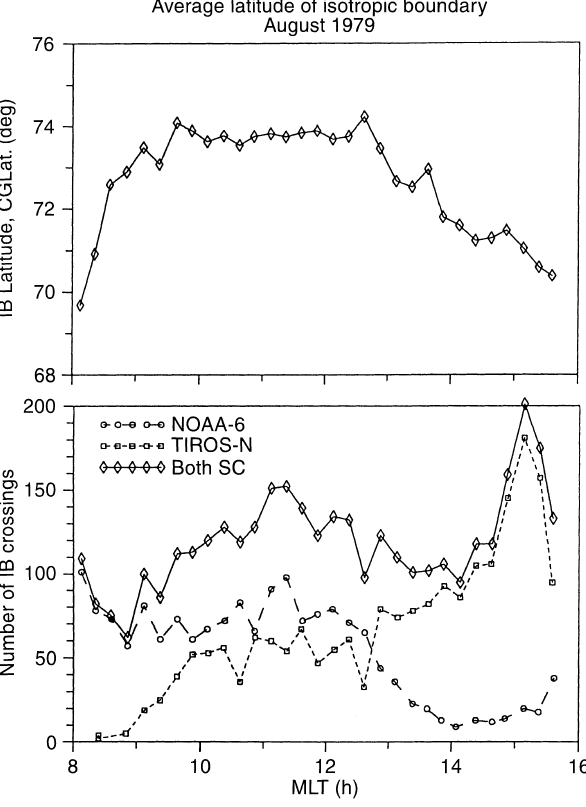
Fig. 8. Statistics of a number of IB crossings near the noon ( bottom , including number of crossings by each spacecraft separately as well as the total number of crossings by two spacecraft) and the average behavior of the IB latitude as a function of MLT (